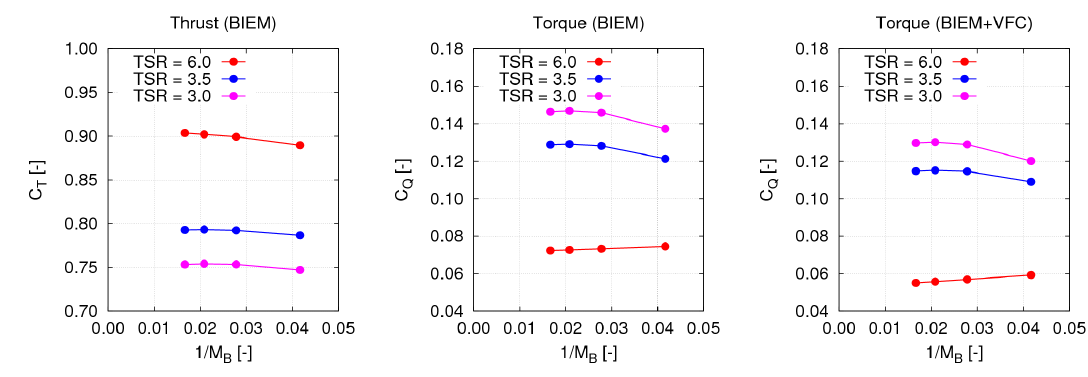
Figure 6. IFREMER-FP turbine. Calculated thrust and torque coefficients as a function of discretization parameter M . Left and center : thrust and torque by non-corrected BIEM; right : torque by BIEM-VFC. B The trailing wake model described in Section 2.1 is used to determine the turbine wake surface.